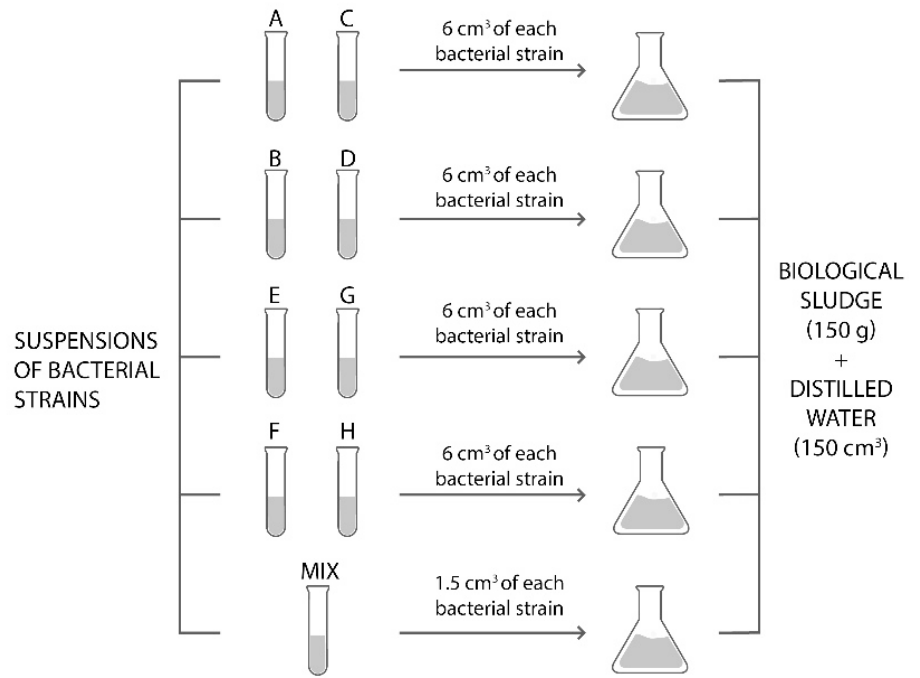
Figure 2. The scheme of preparation of the research material before introduction into the bio ‐ gas ‐ producing fermenter (source: own study). producing fermenter (source: own